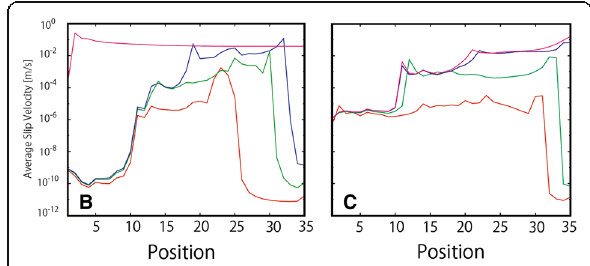
Fig. 9 Snapshots of slip velocities on the fault for parameter sets B and C . Green line shows the slip velocity at the beginning of the mainshock, when the average slip velocity exceeds 1 mm/s, corresponding to the insets in Fig. 5a. The blue and magenta lines are snapshots when the averaged slip exceeds 1 cm/s and reaches its maximum, respectively. The red line is a snapshot taken 1 s before the beginning of the mainshock